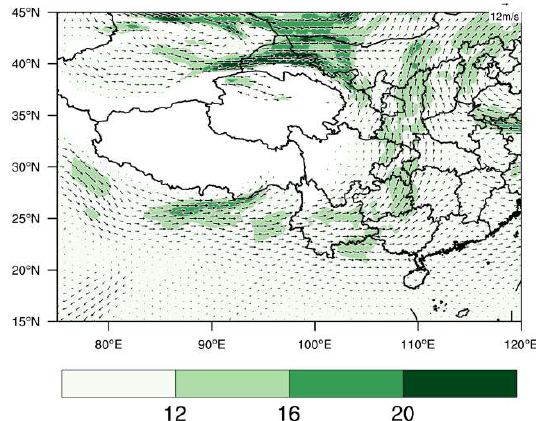
Figure 2. Distributions of wind fields at 700 hPa (vectors, m·s −1 ), LLJ (shading indicates wind speed over 12 m·s −1 ) at 0600 UTC 2 May.